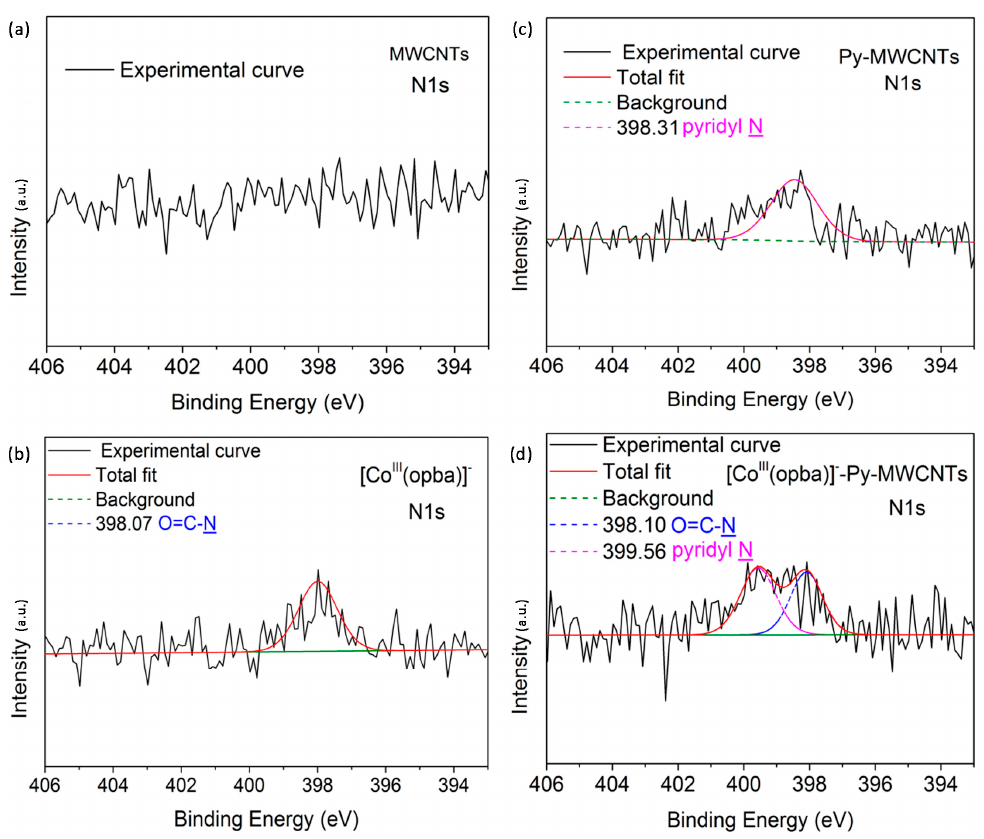
Figure 2. Curve fitting of N1s peaks of ( a ) MWCNTs; ( b ) [Co III (opba)] − ; ( c ) Py-MWCNT and ( d ) [Co III (opba)] − -Py-MWCNTs.